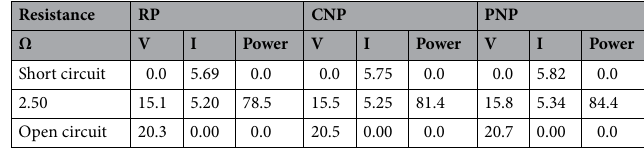
Table 6. Important characteristics for I–V and P–V curves.